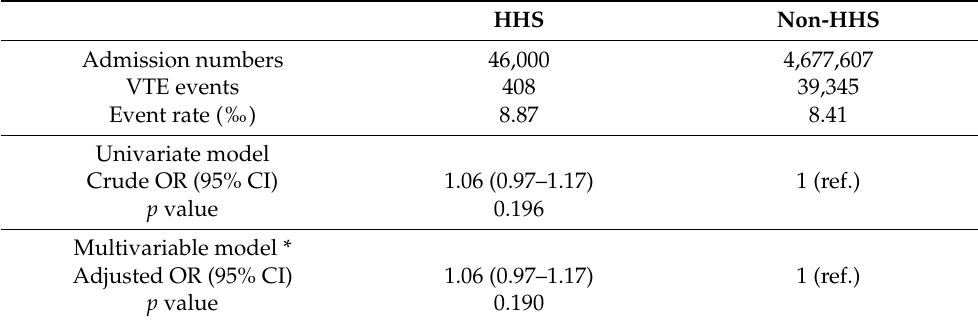
* Multivariable logistic regression model adjusting for all baseline characteristics shown in Table 1. Abbreviations: HHS = hyperosmolar hyperglycemic state; OR = odds ratio; VTE = venous thromboembolism; CI = confidence interval; ref. = reference.